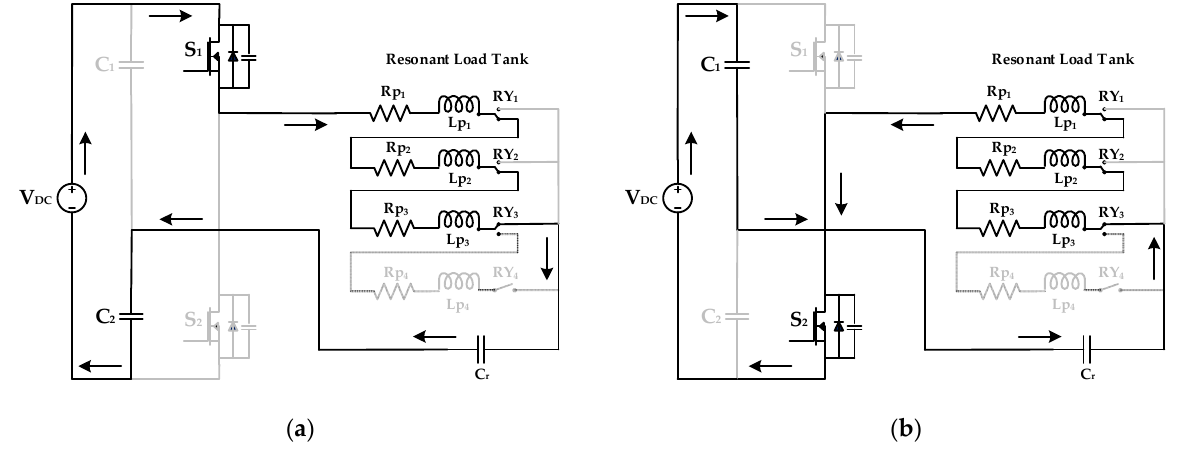
Figure 5. Circuit diagram of Mode 3: ( a ) Switch S 1 in ON state; ( b ) Switch S 2 in ON state.